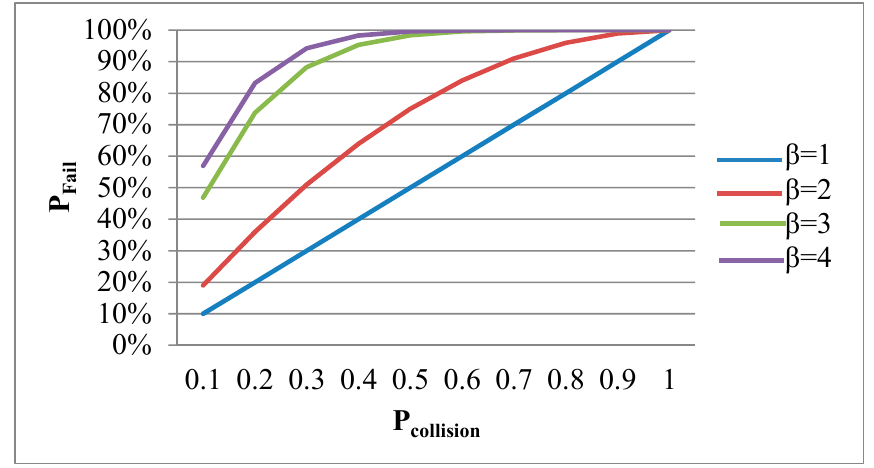
Figure 11. The influence of β on the probability of secondary user (SU) transmission failure in full scan mode.